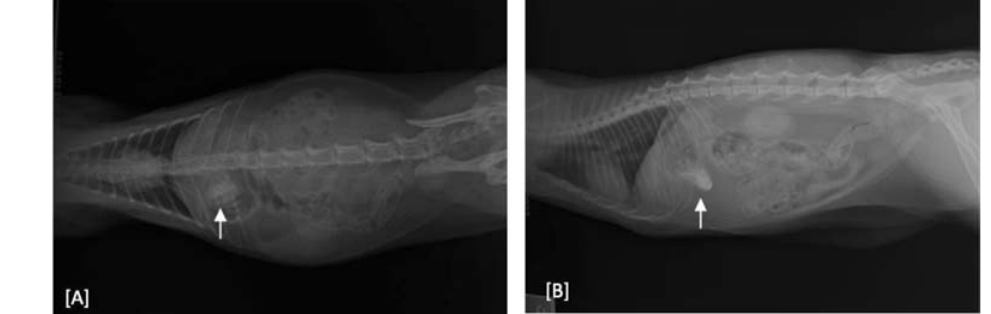
Abdominal radiographs of the cat. [a] Dorsoventral view : Obstruction found in the stomach (white arrow). [B] Latero-lateral view: Obstruction found in the stomach (white